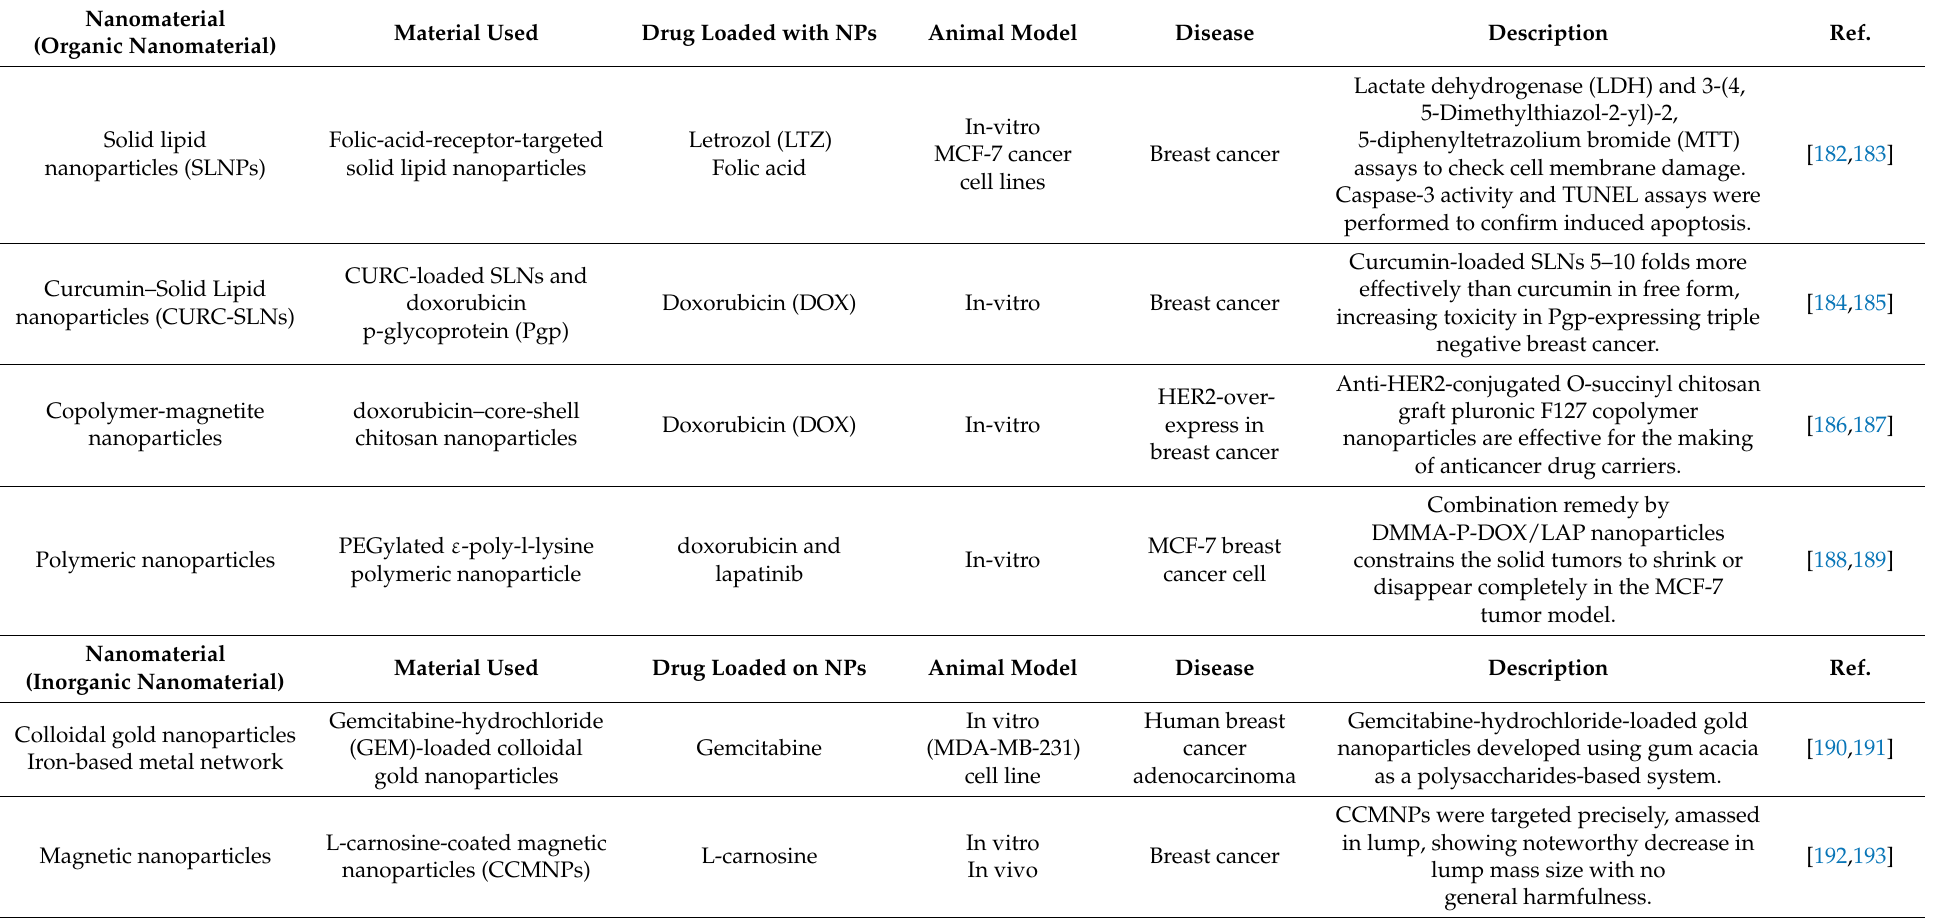
Table 4. Nanoparticles’ role in treatment of breast